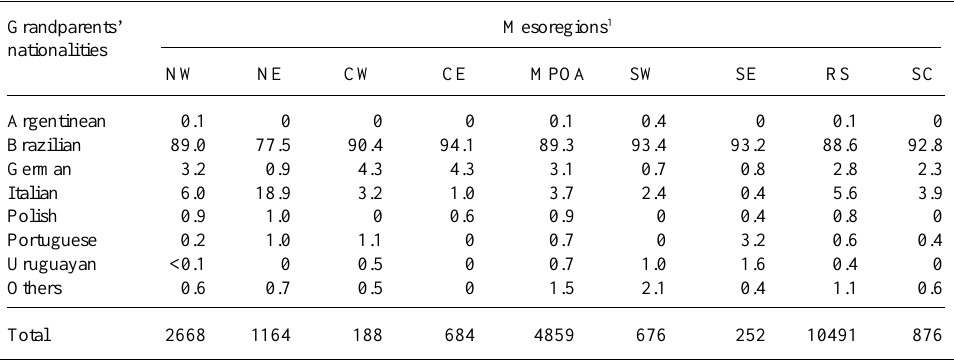
Table III - Distribution (%) of the grandparents’ nationalities of individuals living in the seven mesoregions of the State of Rio Grande do Sul (RS) and in Santa Catarina (SC). Grandparents’